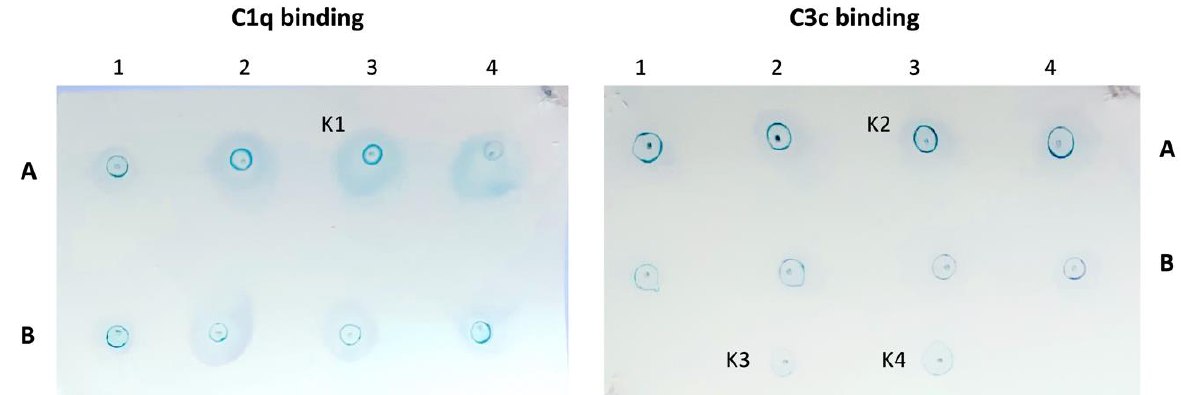
Figure 4. Dot blot C1q and C3c-binding assays performed for membrane proteins (MPs) isolated from serum-resistant (SR) and serum-sensitive (SS) strains. 1 — MPs of SS S. Hammonia, 2 — MPs of SR S . Hammonia P8, 3 — MPs of SS S . Typhimurium ATCC 14028, 4 — MPs of SS S . Typhimurium